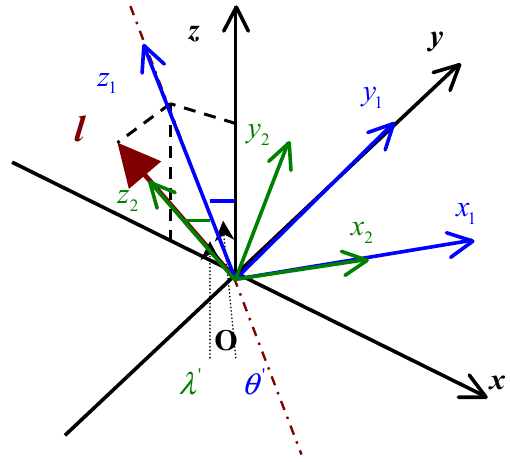
Figure 2. Schematic 3-D rotation for solving the basis vectors of the OS coordinate on the upslope of the terrain. The burgundy arrow is the normal vector of the terrain, and the burgundy dash-dotted line is its projection on the plane Oxz . The black arrows are the basis vectors of the z coordinate, the blue arrows are the basis vectors of the first rotated coordinate (cid:2) O ; x 1 , y 1 , z 1 (cid:3) , and the green arrows are the basis vectors of the second rotated coordinate (cid:2) O ; x 2 , y 2 , z 2 (cid:3) .